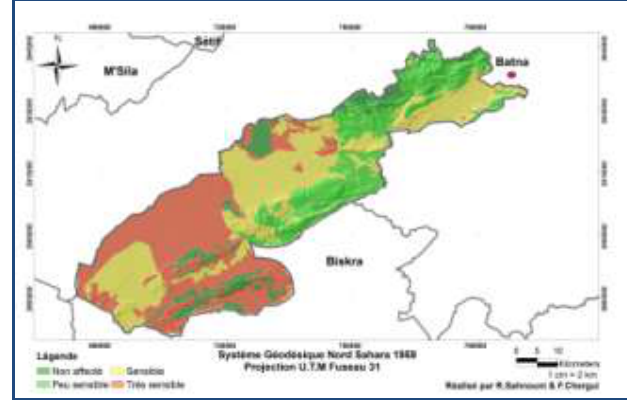
Figure 6. Map of sensitivity to desertification of southern massif